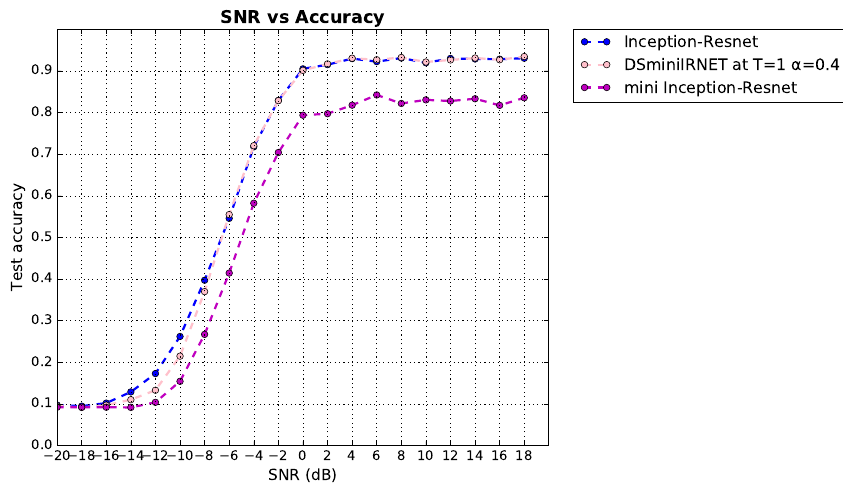
Figure 16. The classification accuracy of the teacher network, student network and the best network after knowledge distillation. (DSminiIRNET represents the mini-Inception–Resnet after knowledge